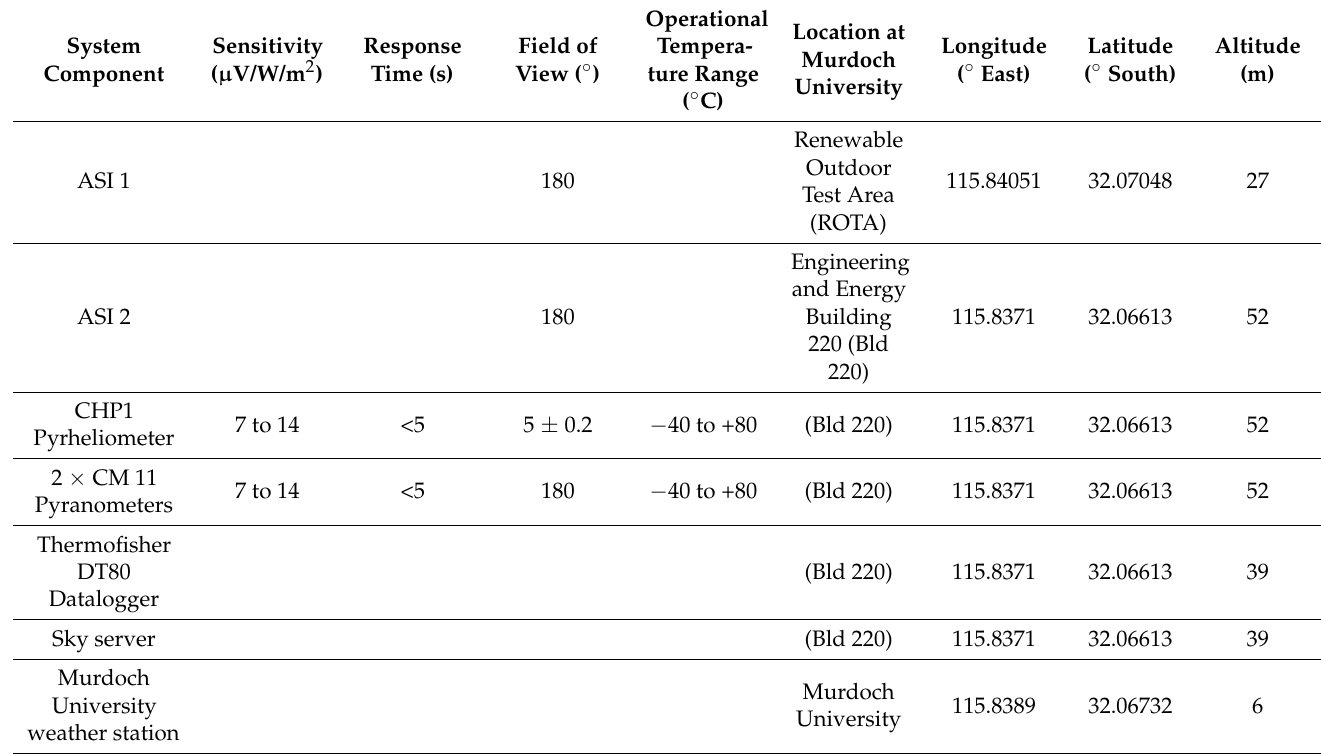
Table 2. Nowcasting system components and